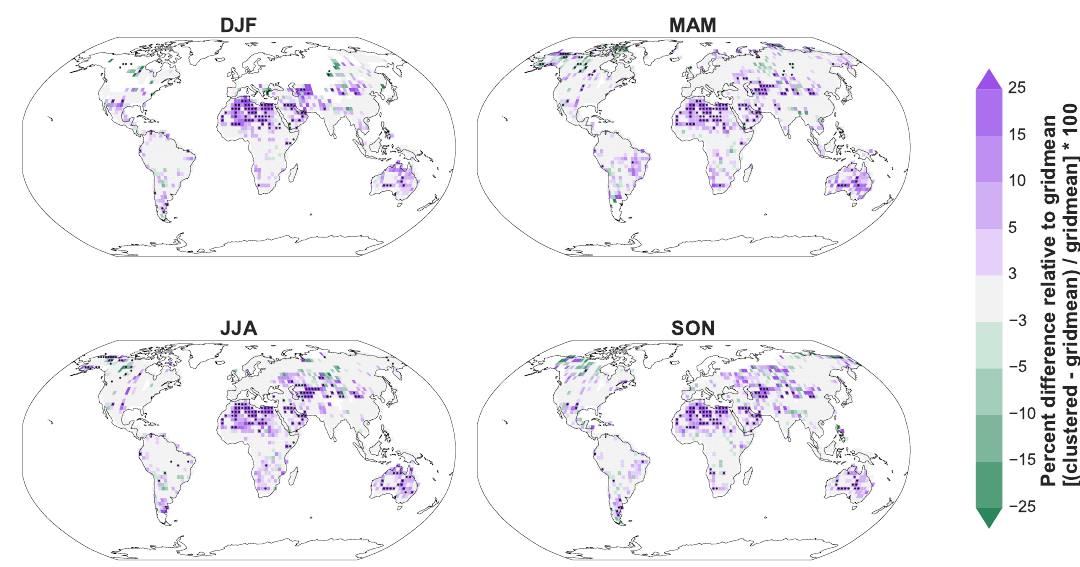
Figure A10. Percent difference in sensible heat fluxes between the Cluster and Gridmean simulations by season (mean of 1995–2015) following Fig. A7.